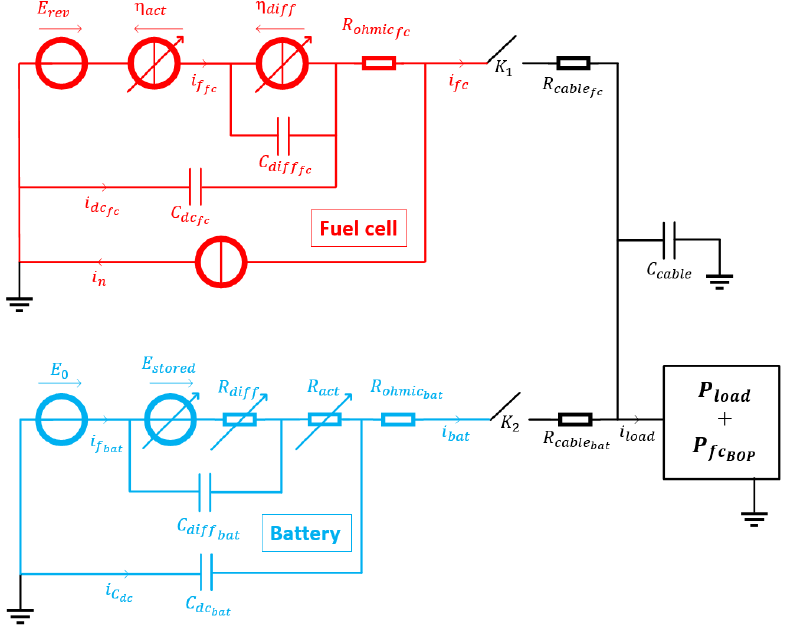
Figure 4. Equivalent circuit dynamic model of a fuel cell–Li-ion battery direct hybridization. The fuel cell dynamic model is constituted by a voltage source representing the reversible Nernst voltage E rev in series with variable current sources representing activation and diffusion overvoltages, respectively η act and η dif f . The current source i n represents